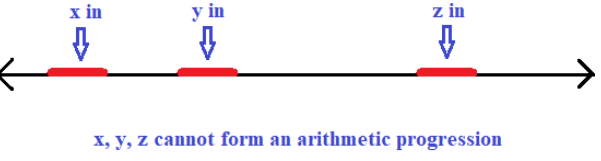
Figure 7. One step in Keleti’s construction of a compact set that avoids